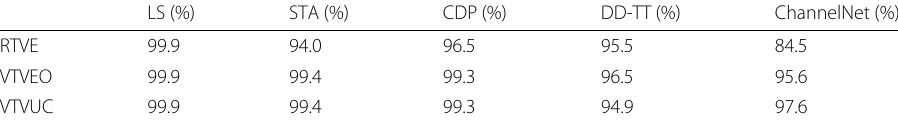
Table 3 The improved percentage of TS-ChannelNet with respect to the compared methods LS (%) STA (%) CDP (%) DD-TT (%) ChannelNet (%) RTVE 99.9 94.0 96.5 95.5 84.5 VTVEO 99.9 99.4 99.3 96.5 95.6 VTVUC 99.9 99.4 99.3 94.9